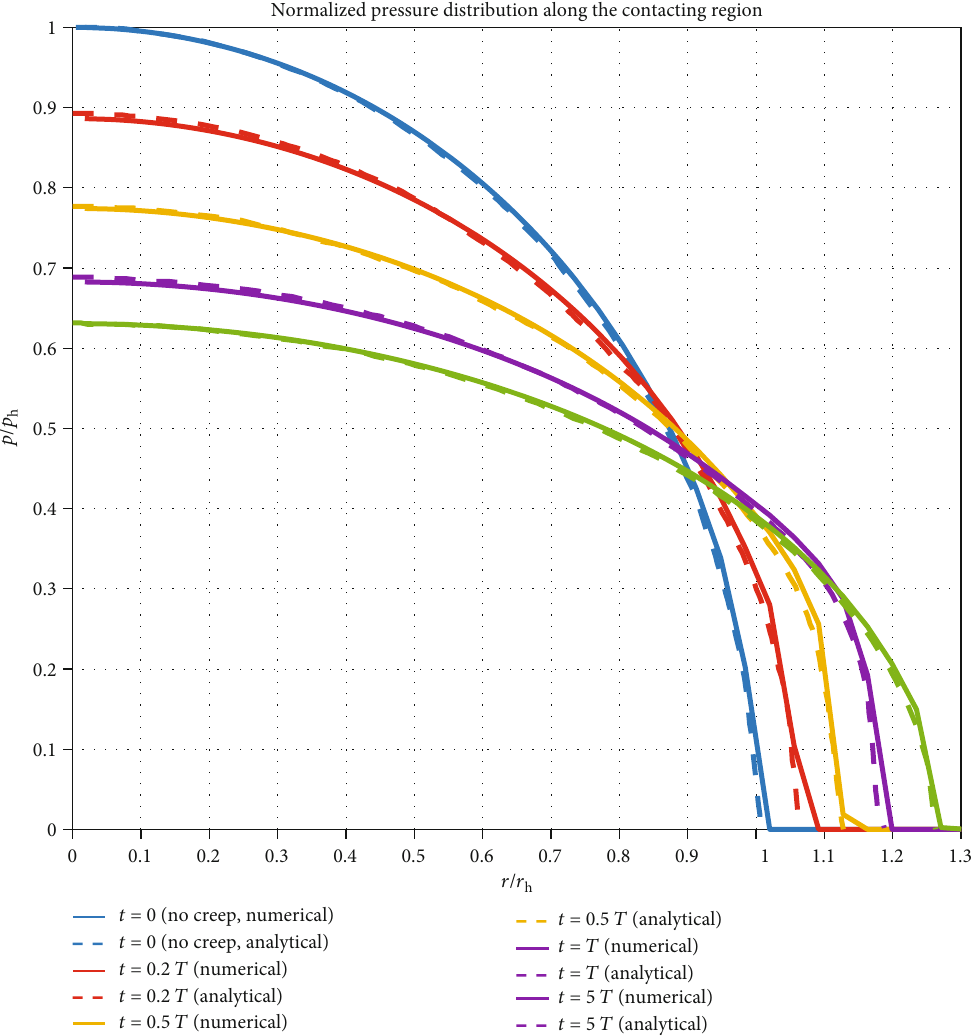
Figure 12: Comparison between analytical solutions ([39]; Johnson, 1985) and the numerical solutions for the SLS model. p maximum pressure when the time is zero (no creep, the solution is Hertzian contact solution), and r region when the time is